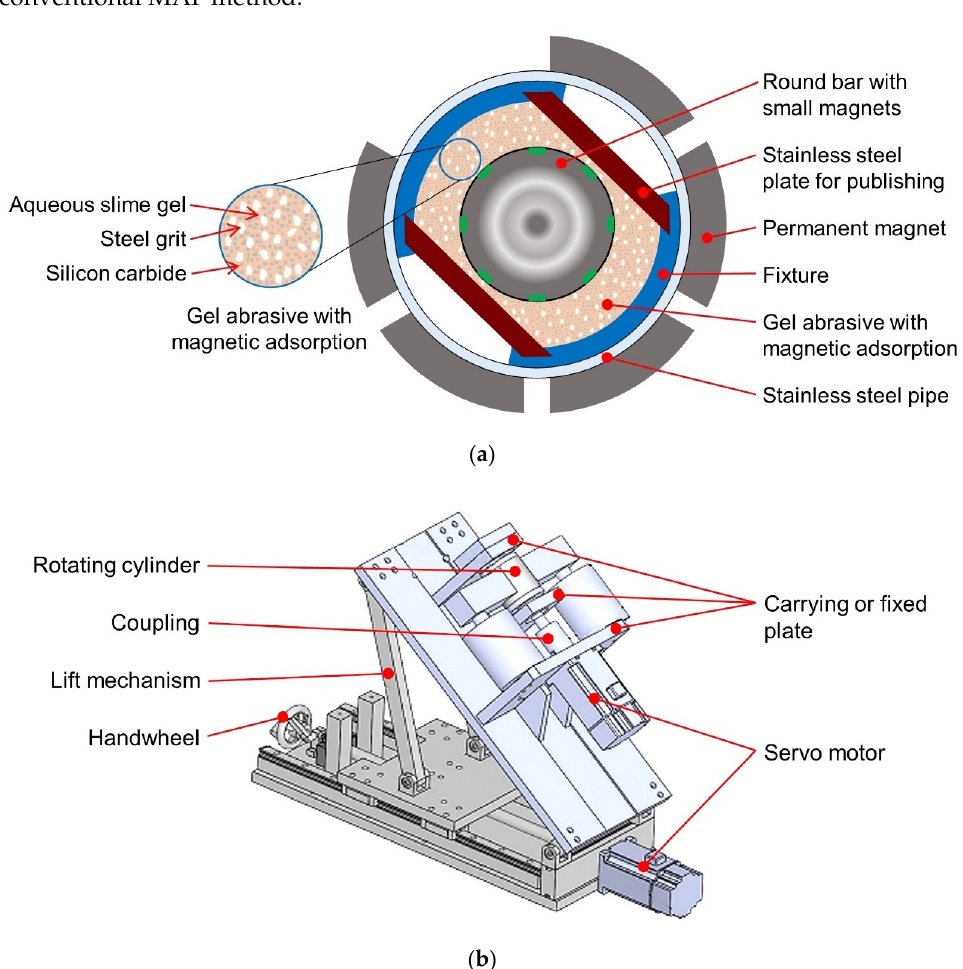
Figure 1. Schematic diagram of the rotating cylinder-based magnetic gel abrasive finishing setup: ( a ) section view of the rotating cylinder; ( b ) the setup configuration.